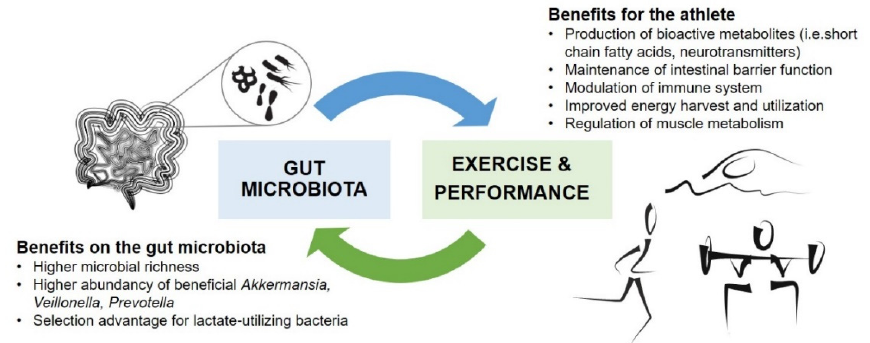
Figure 1. Interactions between gut microbiota and exercise.